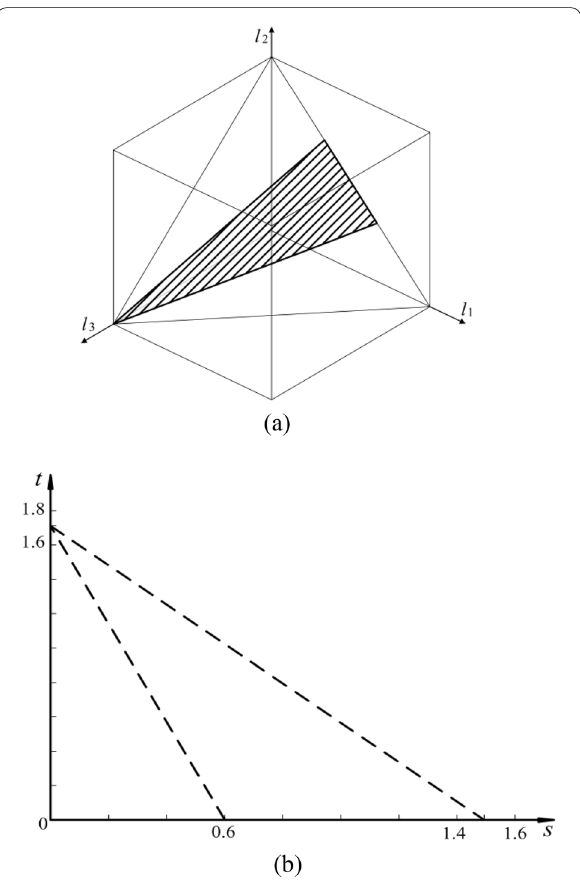
Figure 3 Parameter design space: a Spatial parameter design space, b Plan parameter design